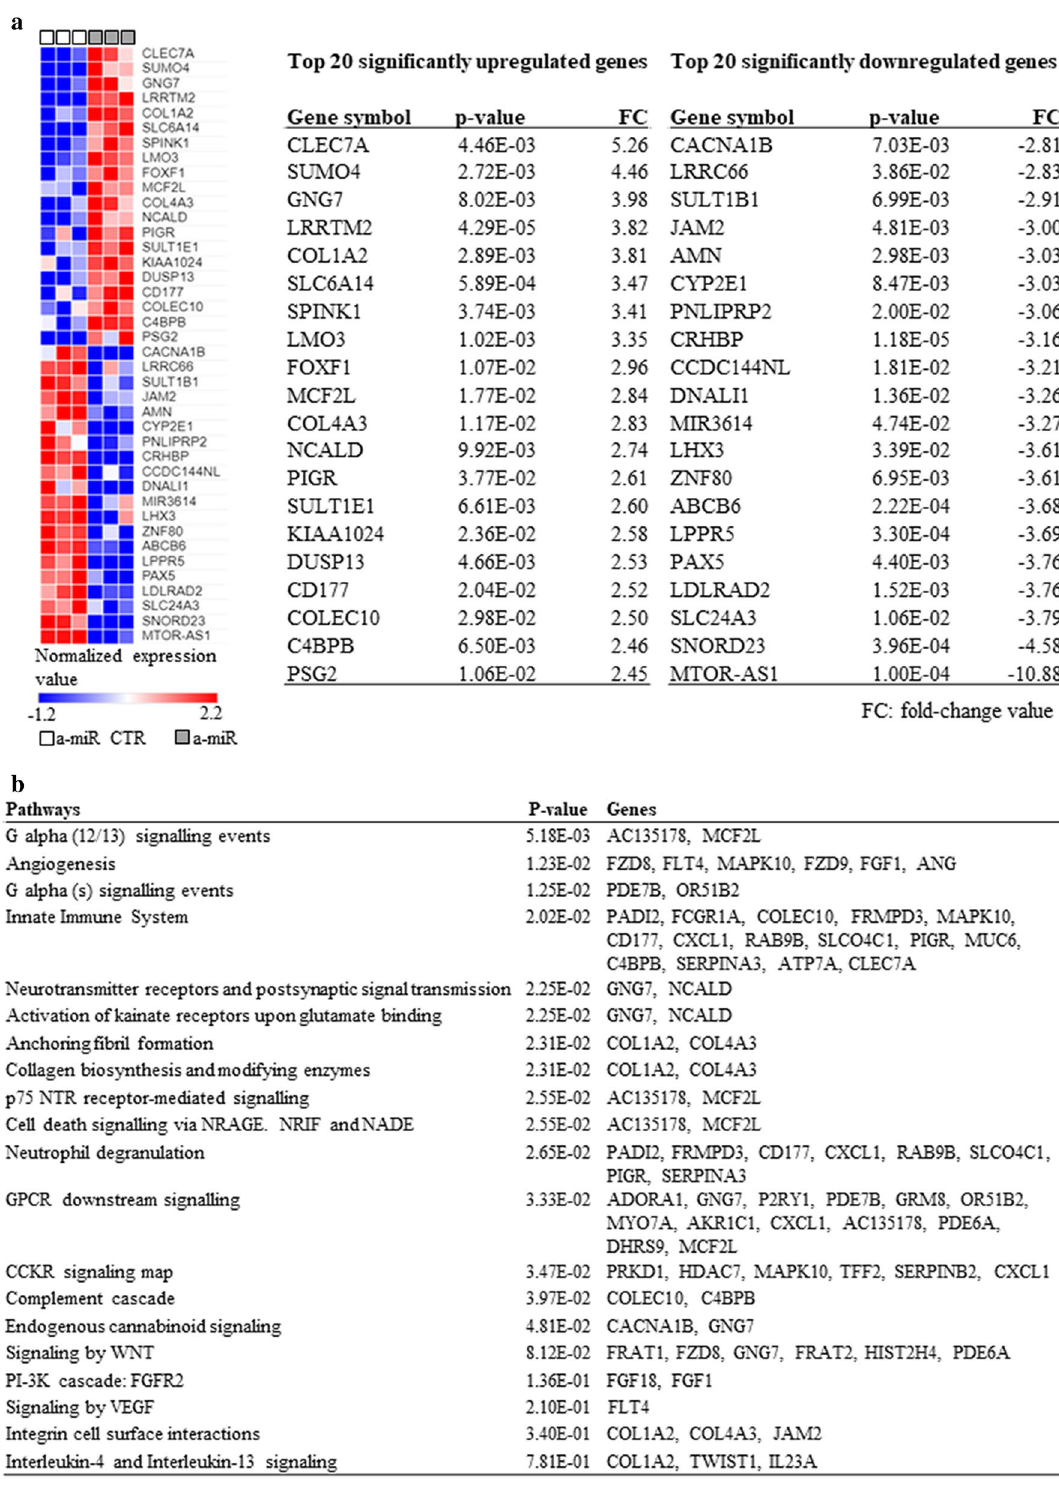
Figure 4. Whole transcriptome analysis of SZ95 sebocytes treated with miR-146a inhibitor for 72 h (n = 3). ( a ) Heatmap visualization and the normalized expression values of the top twenty significantly up- and downregulated genes as revealed by our RNAseq measurements. P-values were calculated using moderated t test method, p-values < 0.05 were considered as statistically significant. ( b ) Pathway analysis of significantly regulated genes using PANTHER Classification System (v.16.0). P-values were calculated using Mann–Whitney U test (integrated to PANTHER Classification System), p-values < 0.05 were considered as statistically